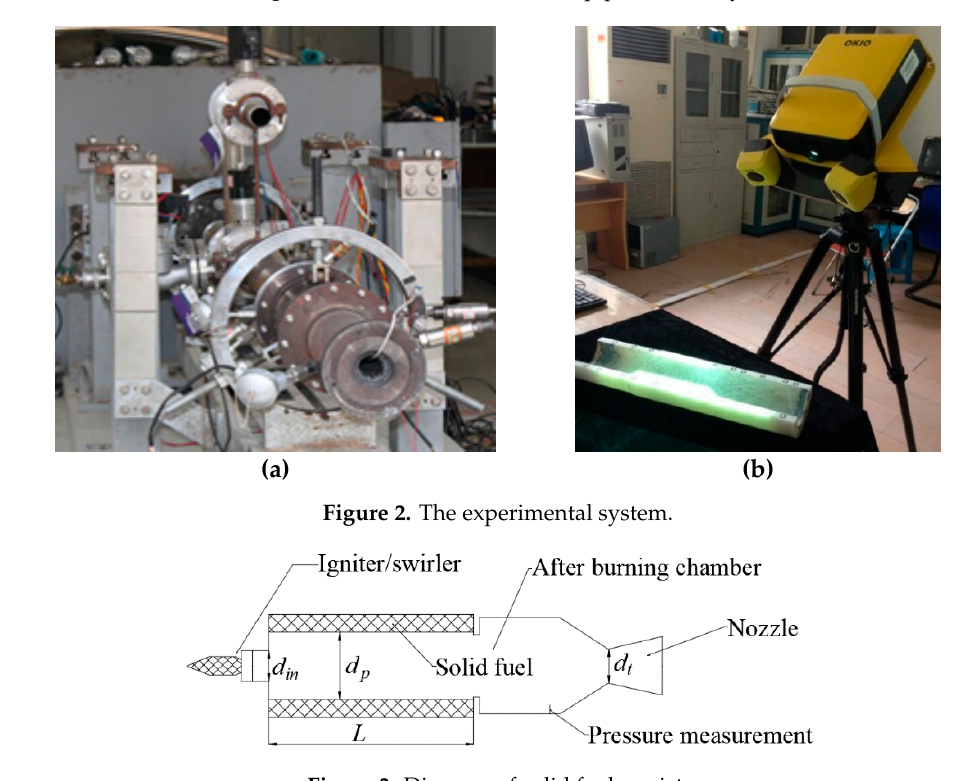
Figure 3. Diagram of solid fuel ramjet.